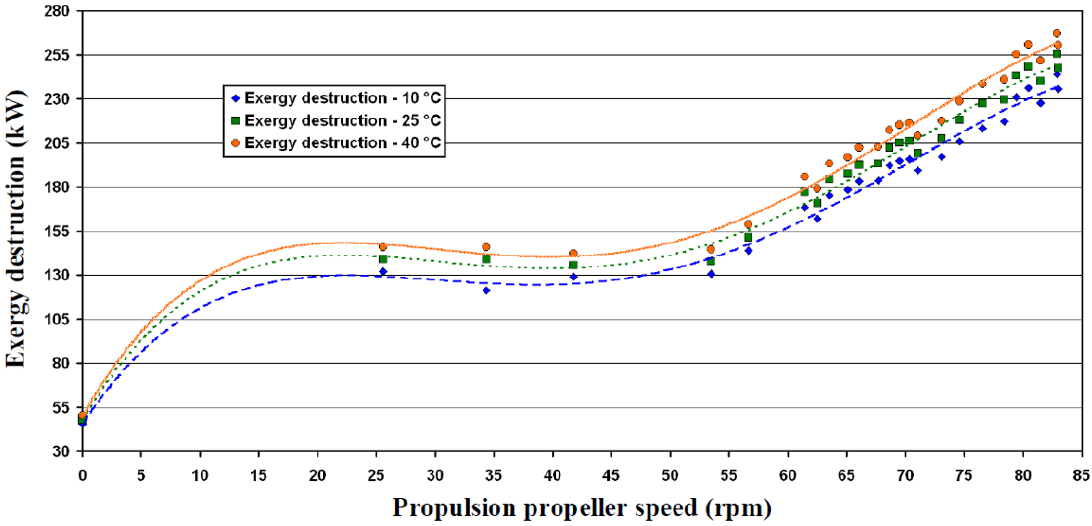
Figure 9. Steam air heater exergy destruction for the several ambient temperatures.